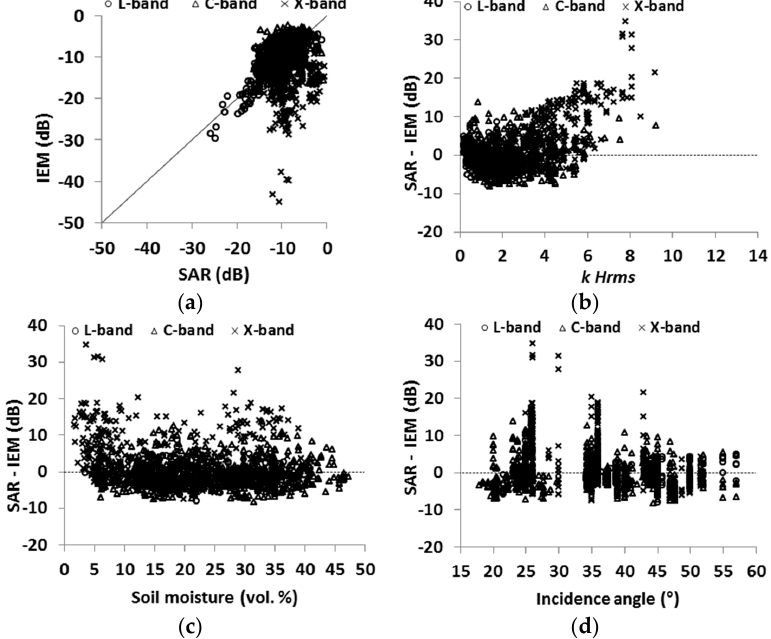
Figure 9. Comparison between backscattering coefficients derived from SAR images and those estimated from IEM at HH polarization using ECF. ( a ) IEM simulations vs. SAR data; ( b ) difference between SAR signal and IEM vs. soil roughness ( kHrms ); ( c ) difference between SAR signal and IEM vs. soil moisture ( mv ); ( d ) difference between SAR signal and IEM vs. incidence angle.